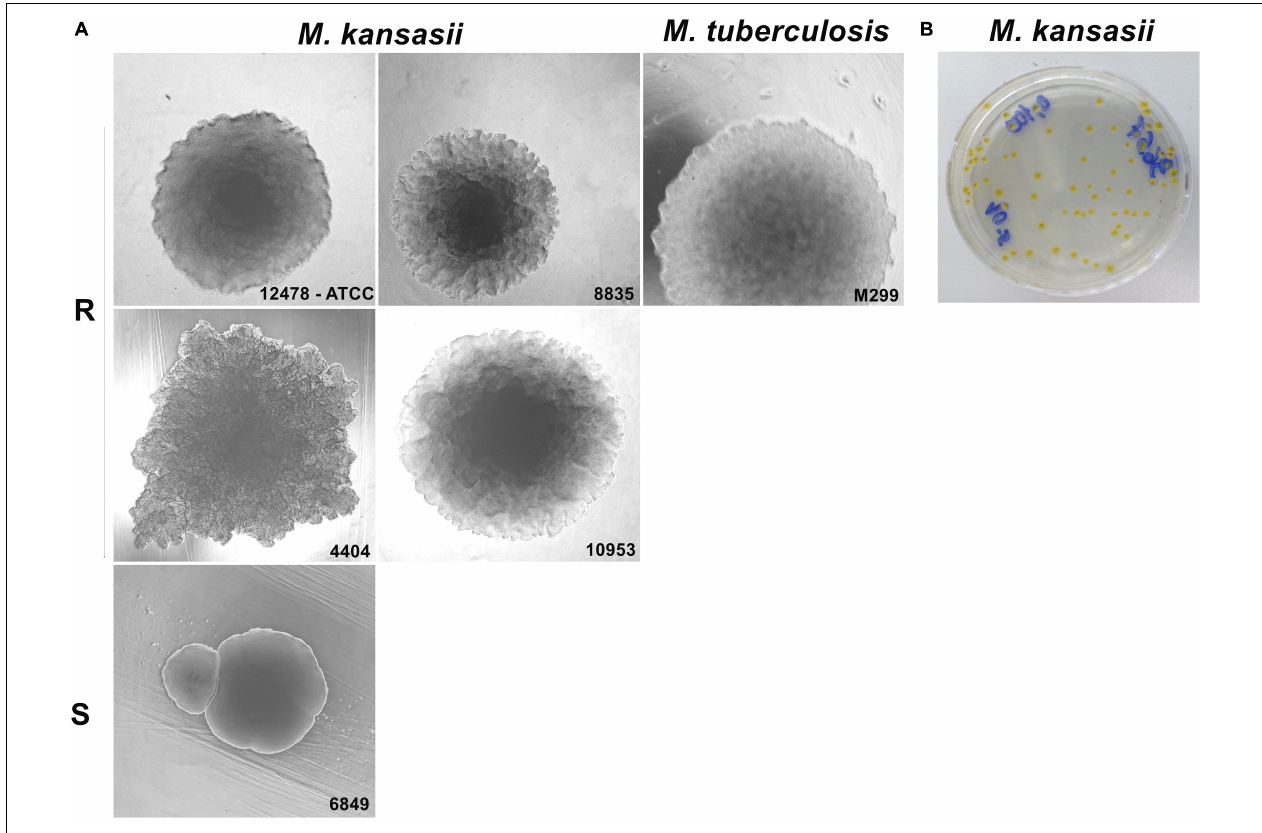
FIGURE 1 | Colony morphotype variants of Mycobacterium kansasii strains. Mycobacterial strains were grown on Middlebrook 7H10 agar for 21 days ( M. kansasii ) and 28 days ( Mycobacterium tuberculosis ), and the macrocolony images were captured. (A) M. kansasii clinical isolates (images are demonstrated for strains 8835, 4404, and 10953) exhibited a rough colony shape (R) similar to that of the reference M. kansasii strain 12478 or the M. tuberculosis strain H37Rv, with exception of the isolate 6849, which showed smooth morphotype (S). (B) All M. kansasii strains grown on the agar exhibited yellow colonies under exposure to light.